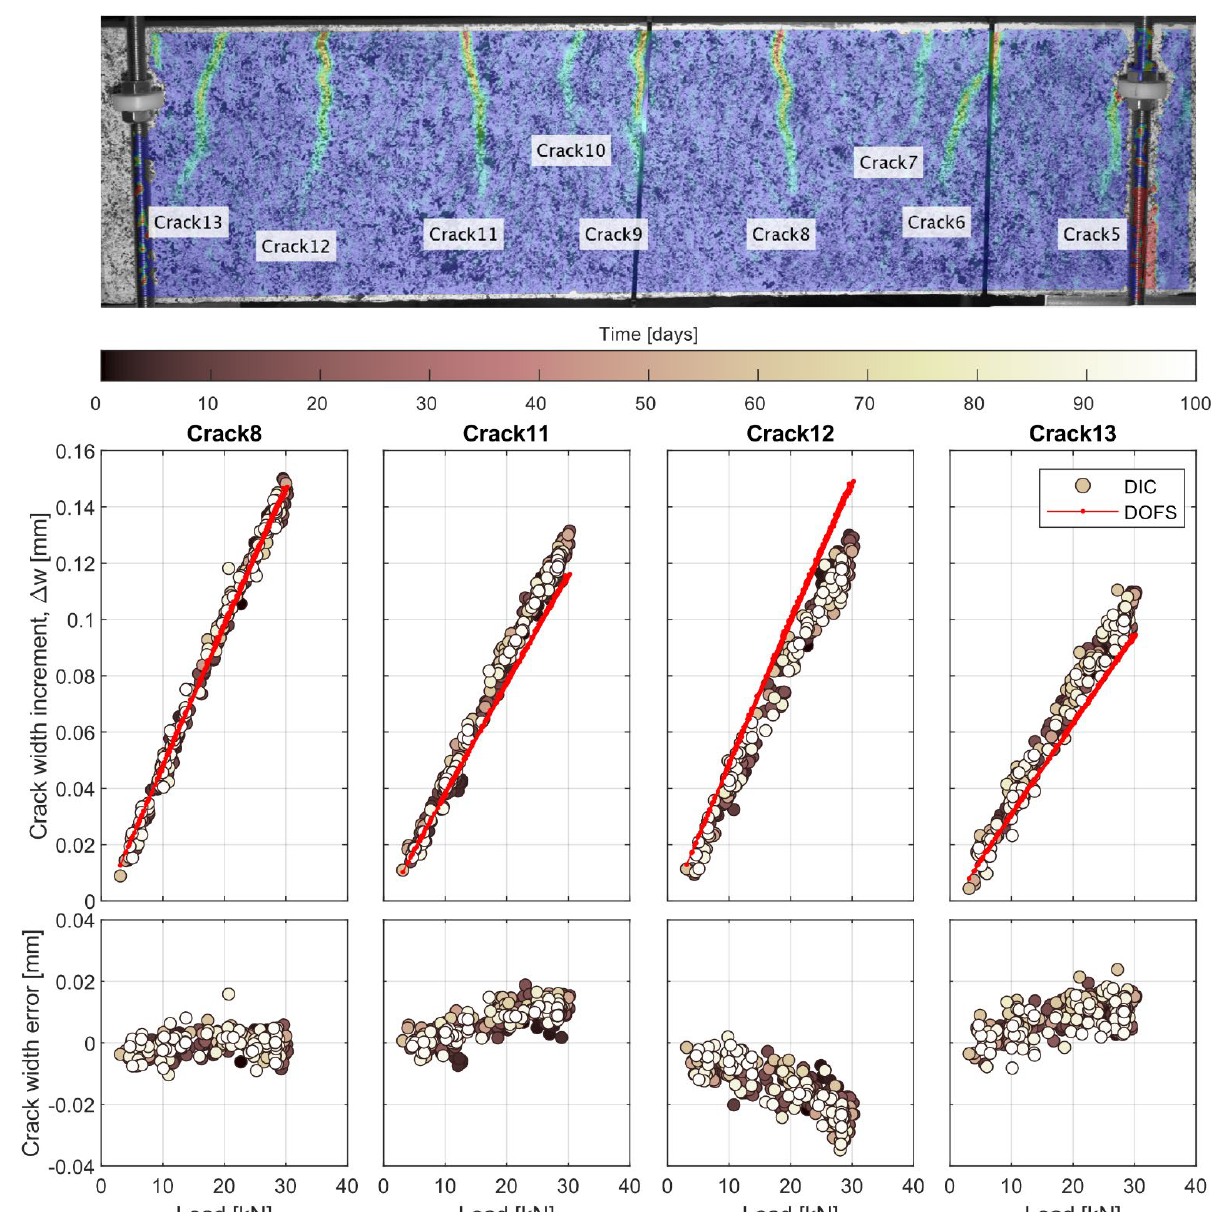
Figure 12. Results of the DIC showing the field of principal strains to highlight the position of cracks on the surface of beam 4 along the region of constant bending moment ( top ). Relationship between increment of crack width and applied load for selected cracks ( middle ). Crack width error between the DIC and DOFS measurements ( bottom ).